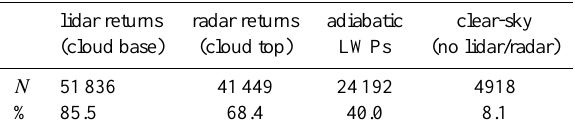
Table 1. Number of 1Hz samples influencing cloud boundary statistics from thirteen research flights (these excluded RF9). Radar returns include those for which the altitude of maximum reflectivity is used as a cloud top proxy. Cloud-base legs are excluded. The percentages assume a total of 60590.